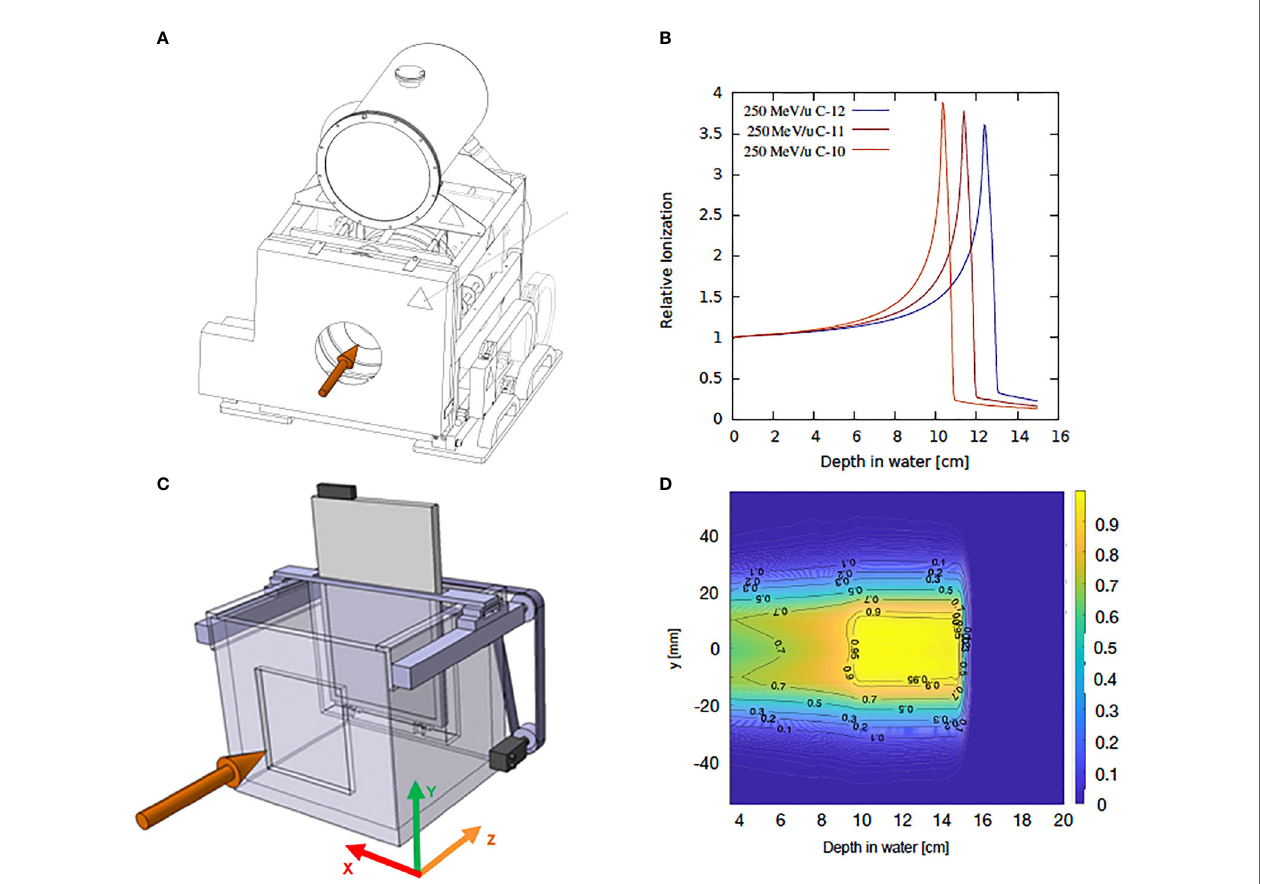
FIGURE 4 | Schematic representation of the experimental setup and typical dose distributions measured with water column and the WERNER setup. (A) Technical drawing of the water column. (B) FLUKA simulation of laterally integrated 1D depth dose distribution for carbon ion isotopes of 250 MeV/u. (C) schematic representation of the WERNER setup. (D) 2D dose distribution map for a 4 cm- 12 C